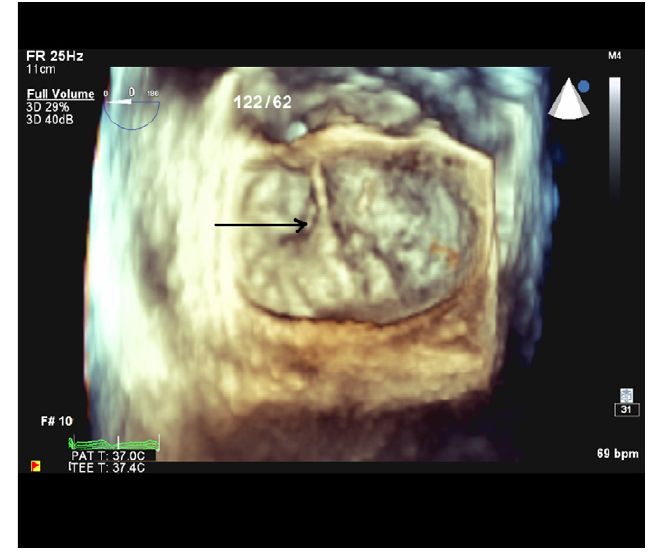
Figure. 6 An example of a 3D echocardiograph image of Barlow’s valve with chordae rupture involving medial segment of P2 (arrow) with thickened leaflets without a leaflet closure line.